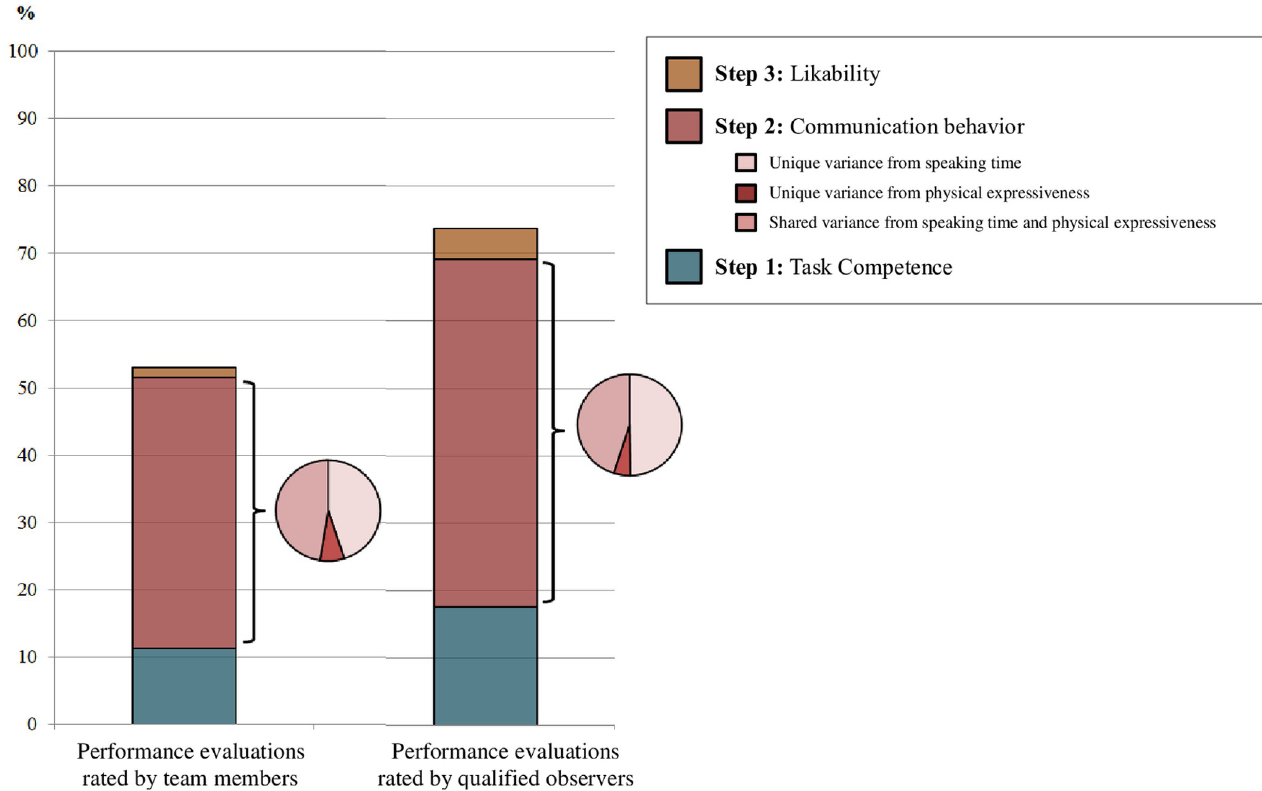
Fig 2. Amounts of variance explained in the hierarchical fixed effects regression for team members’ and qualified observers’ performance